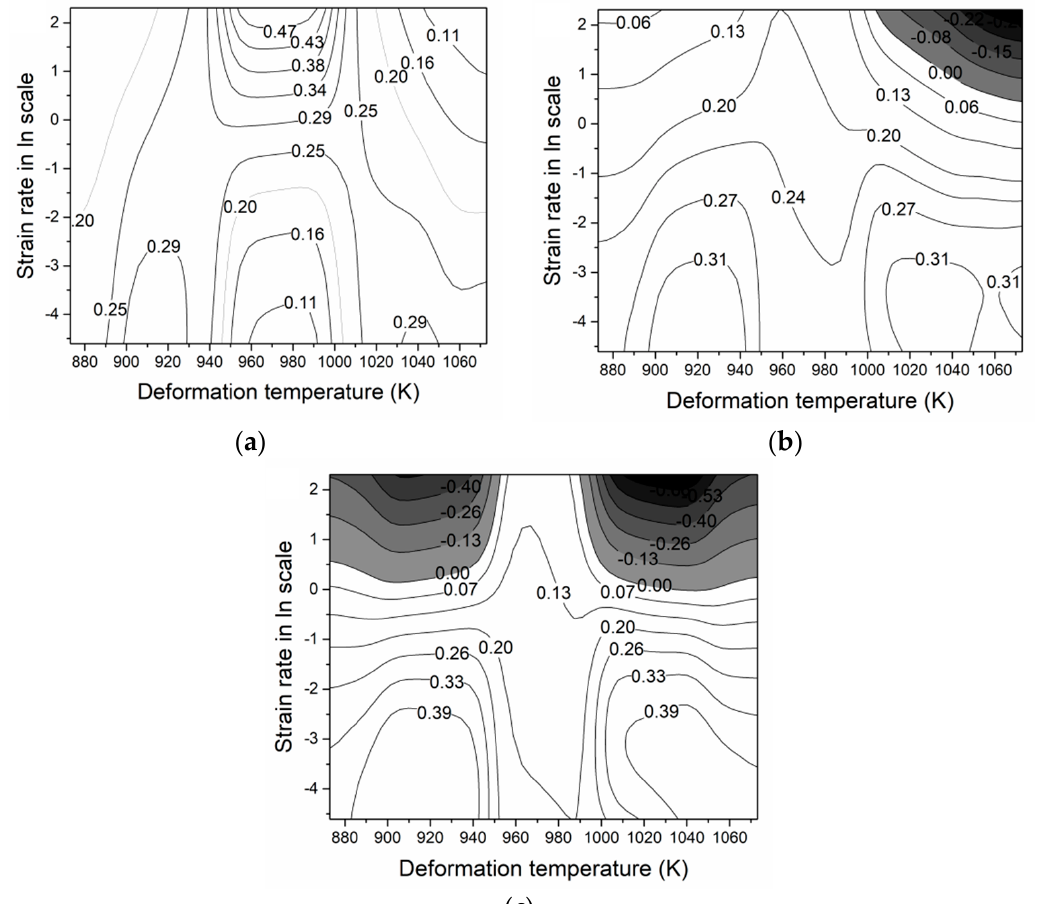
Figure 9. The contour maps of the instability region at various strain levels: ( a ) strain at 0.3, ( b ) strain